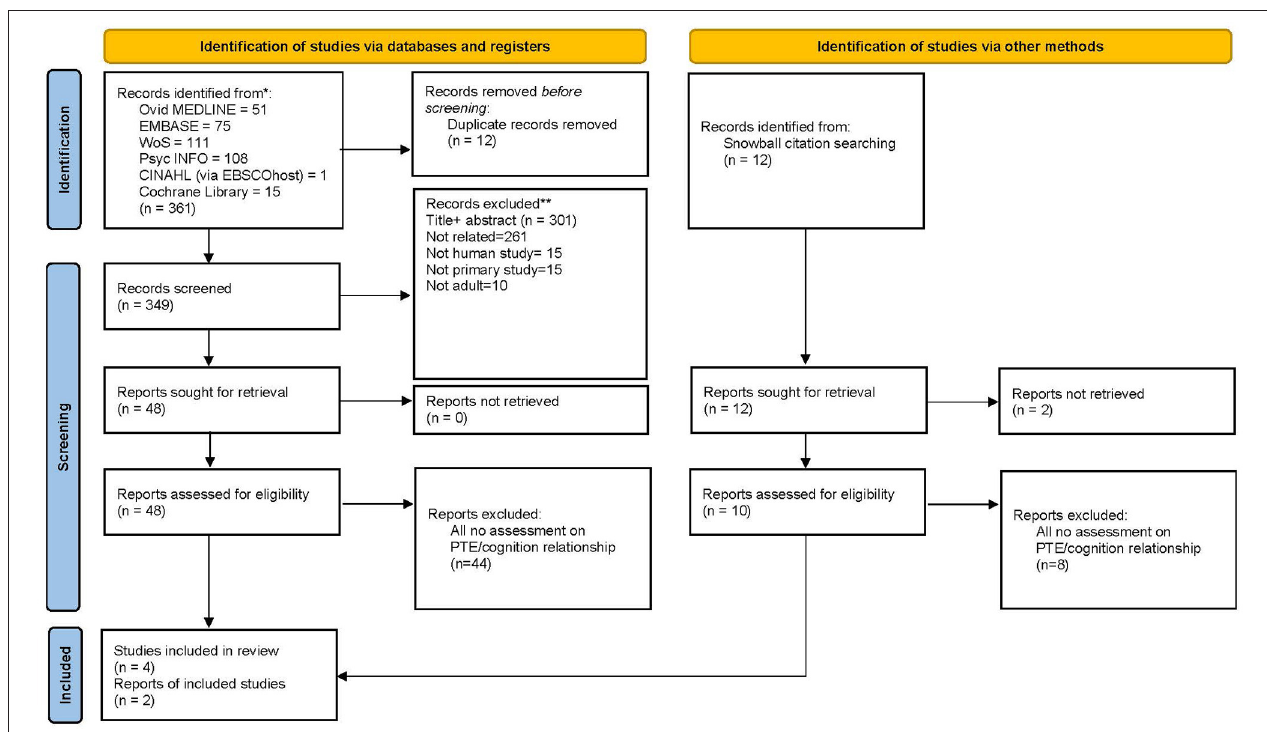
FIGURE 1 | PRISMA 2020 flow diagram for new systematic reviews which included searches of databases and other sources used in this